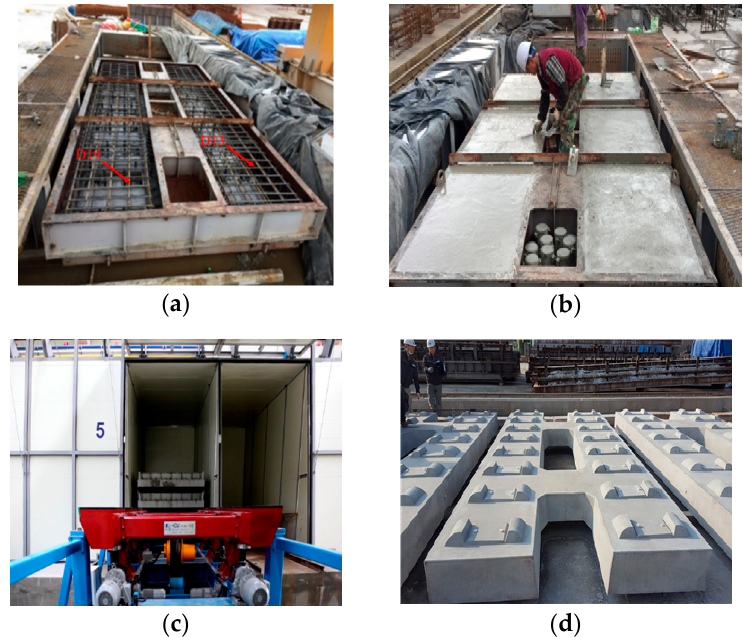
Figure 4. Fabrication process of precast floating panel: ( a ) assembly of rebar, ( b ) concrete pouring, ( c ) curing, and ( d ) prototype of precast floating panels.